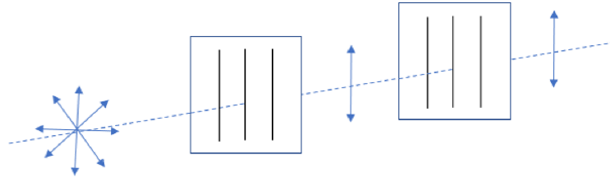
FIG. 3. Schematic representation of one part of the experiment with two polarizers, as typically shown in high school physics textbooks. Vertical lines are representing the polarizing axes of the